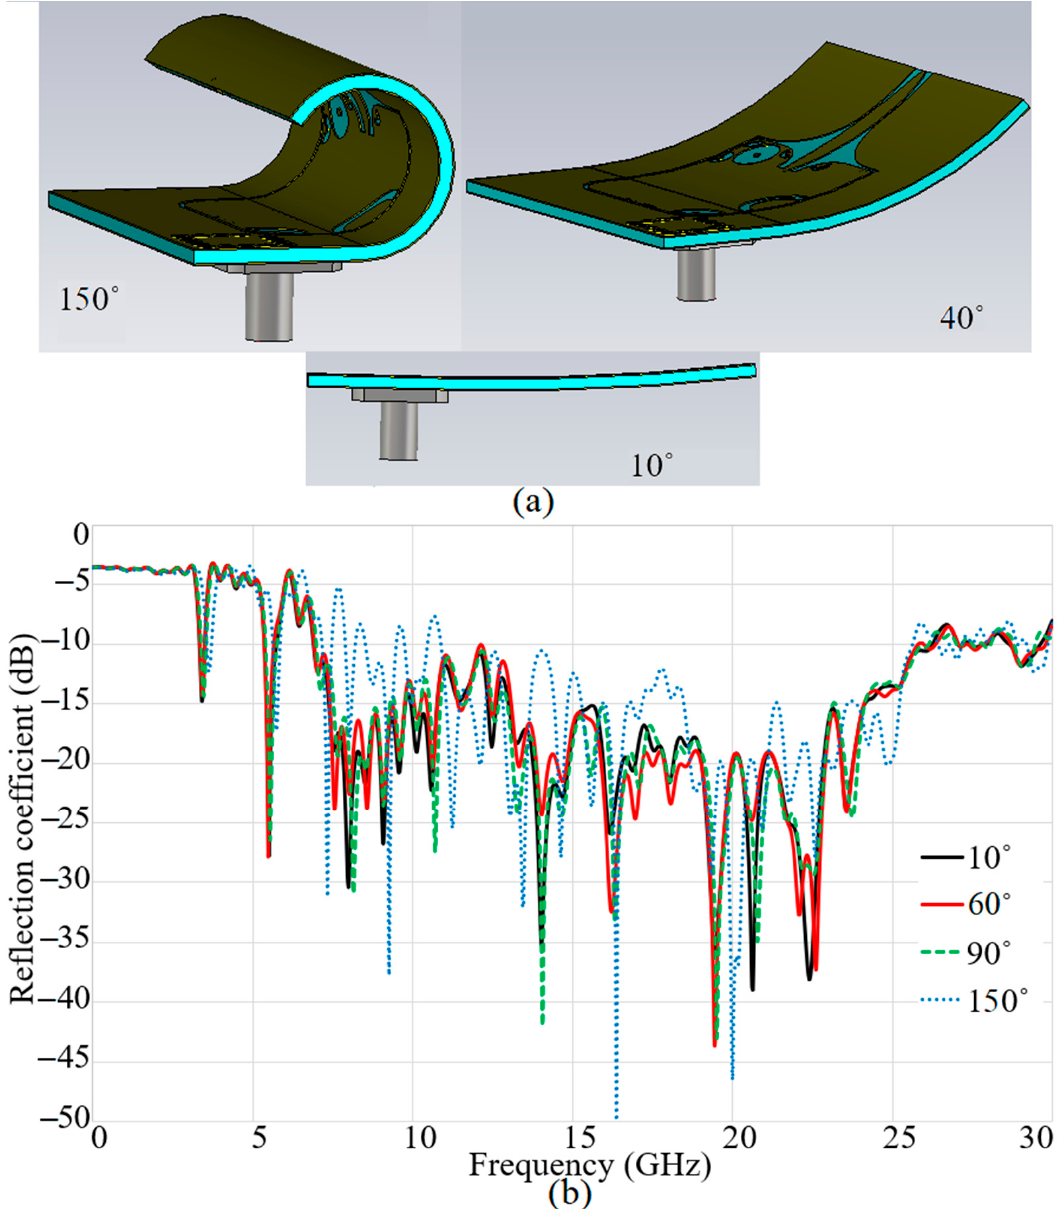
Figure 7. The antenna’s reflection coefficient results in different bending degrees: ( a ) bended prototype and ( b ) reflection coefficient results.